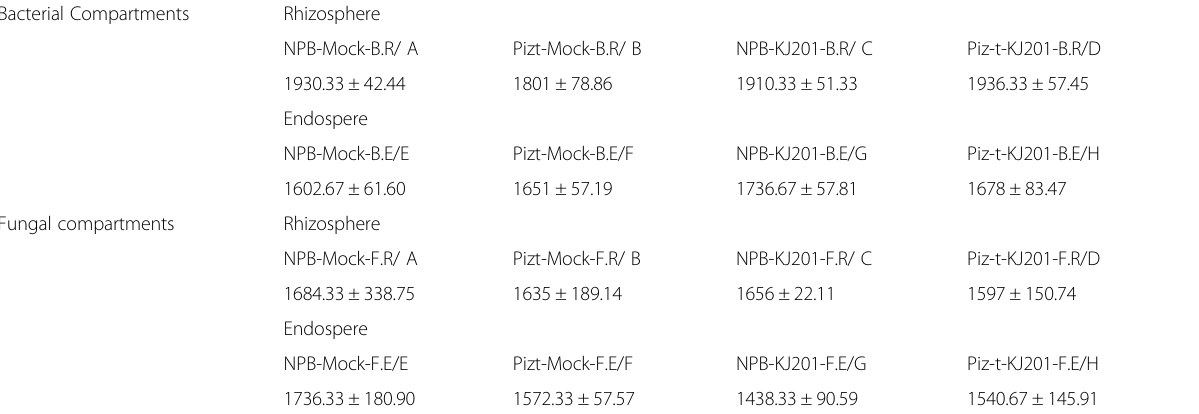
Table 1 The eight samples and their sequencing OTUs in rhizospheric and endospheric microbiota Bacterial Compartments